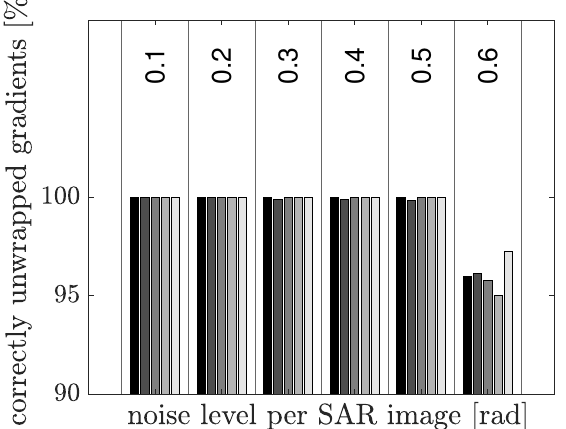
Figure 12. Percentage of correctly unwrapped phase gradients depending on the noise